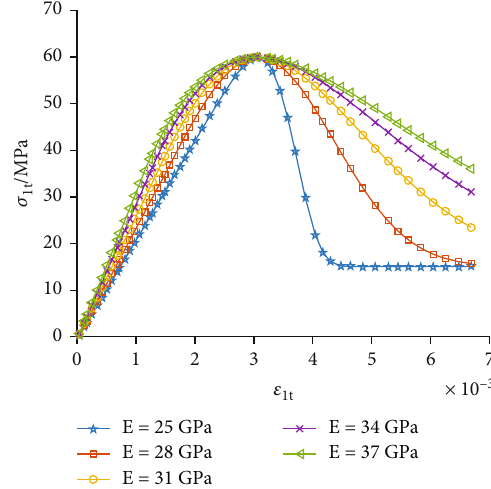
Figure 4: Deformation modulus sensitivity analysis.